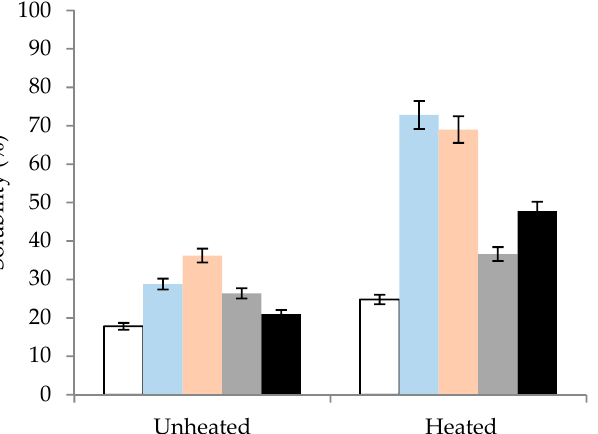
Figure 4. Solubility of unheated and heated (90 °C × 20 min) soy protein isolate dispersions measured at pH 6.9 ( □ ), pH 9.0 ( ■ ), pH 2.0 ( ■ ), and pH 6.9 readjusted after heat treatment at pH 9.0 ( ■ ) and pH 6.9 readjusted after heat treatment at pH 2.0 ( ■ ).